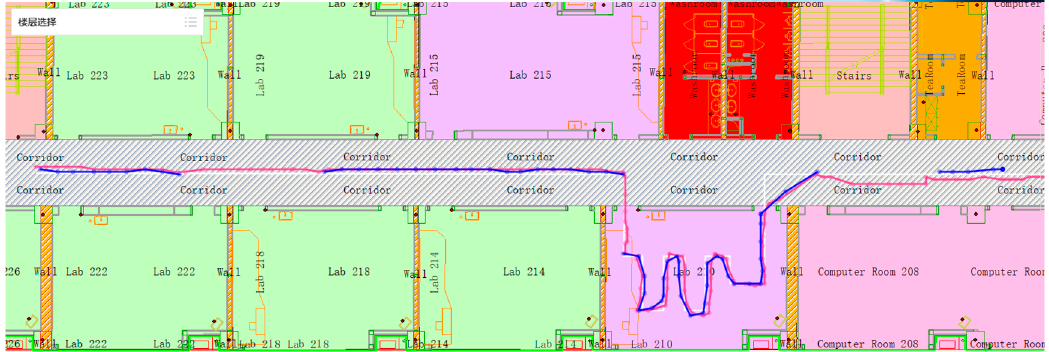
Figure 16. Pedestrian trajectory with UWB unlock in most of the corridor. Figure 15. Pedestrian trajectory with UWB unlock 5 seconds*3 times. Figure 15. Pedestrian trajectory with UWB unlock 5 seconds*3